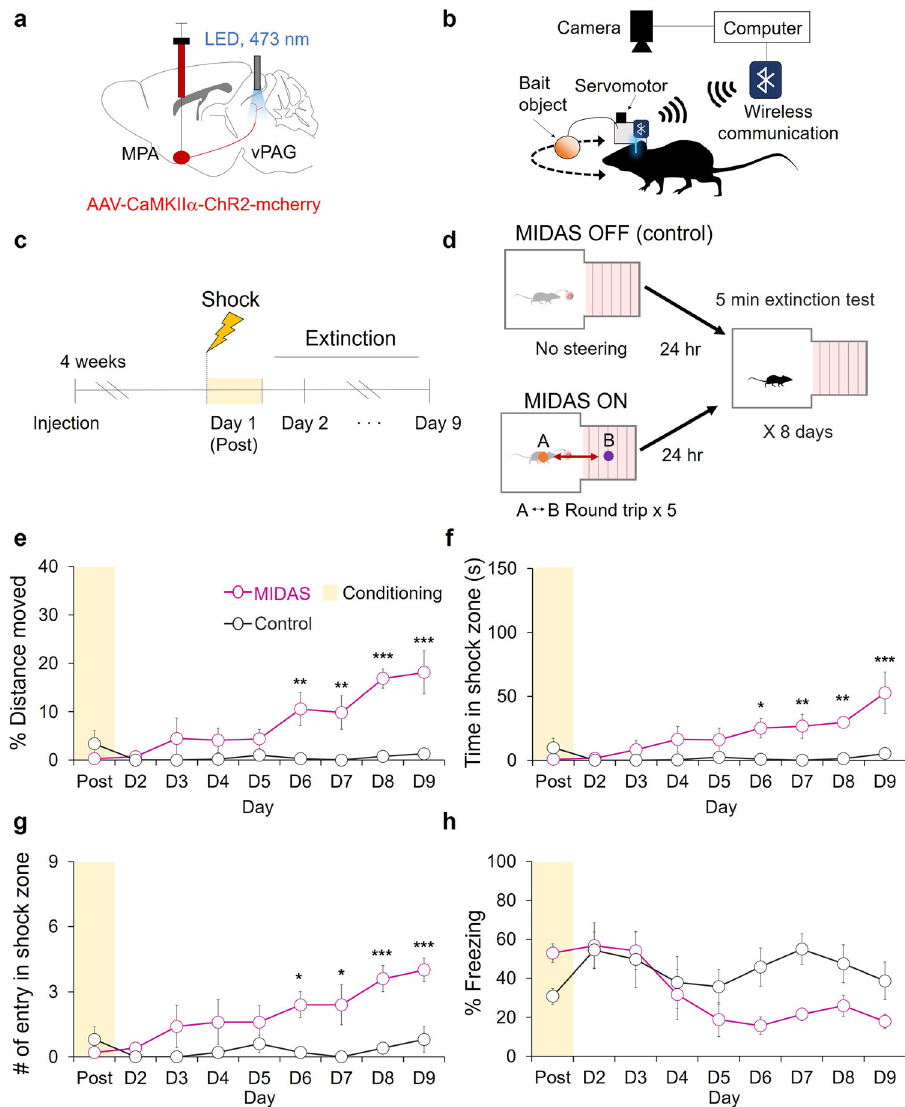
Fig. 5 MIDAS-driven shock zone exploration induces fear extinction. a A schematic depiction of virus injection and photostimulation (3 mW, 20 Hz, 5 ms). b A schematic depiction of the MIDAS system. c The fear-conditioning and extinction test schedules. d MIDAS exploration and extinction testing during fear extinction. e The percentage of distance moved in the shock zone during the extinction test for the MIDAS group (Magenta, n = 5) and the control group (gray, n = 5; two-way RM ANOVA test, Holm-Sidak post-hoc analysis). f Time in the shock zone during fear extinction for the MIDAS group (Magenta, n = 5) and the control group (black, n = 5; two-way RM ANOVA test, Holm-Sidak post-hoc analysis). g The number of entries into the shock- paired zone during fear extinction for the MIDAS group (Magenta, n = 5) and the control group (black, n = 5; two-way RM ANOVA test, Holm-Sidak post- hoc analysis). h The percentage of freezing into the shock-paired zone during fear extinction for the MIDAS group (Magenta, n = 5) and the control group (black, n = 5; two-way RM ANOVA test, Holm-Sidak post-hoc analysis). * p < 0.05. ** p < 0.01, *** p < 0.001. All error bars represent s.e.m. Further information on statistical analyses is given in the supplementary data